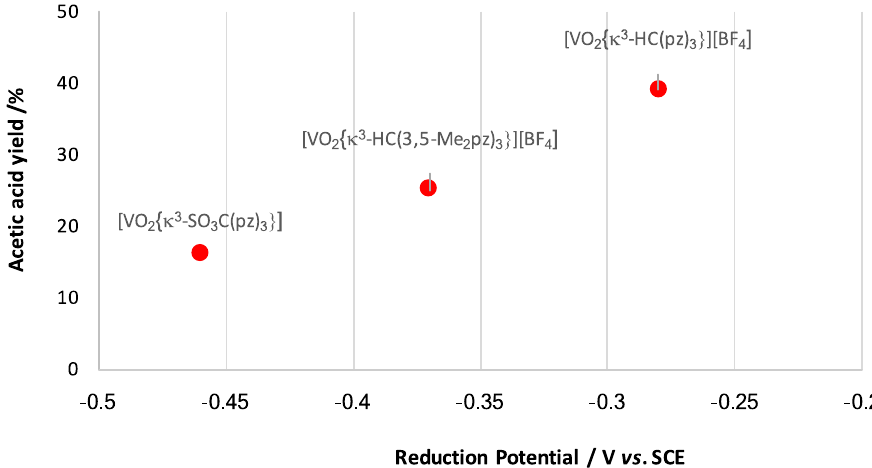
Figure 7. Yields of acetic acid produced from the one ‐ pot carboxylation of methane catalyzed by the V(V) complexes [VO 2 { κ 3 ‐ HC(pz) 3 }][BF 4 ], [VO 2 { κ 3 ‐ HC(3,5 ‐ Me 2 pz) 3 }][BF 4 ] and [VO 2 { κ 3 ‐ SO 3 C(pz) 3 }] vs. their V(V) to V(IV) reduction potentials.